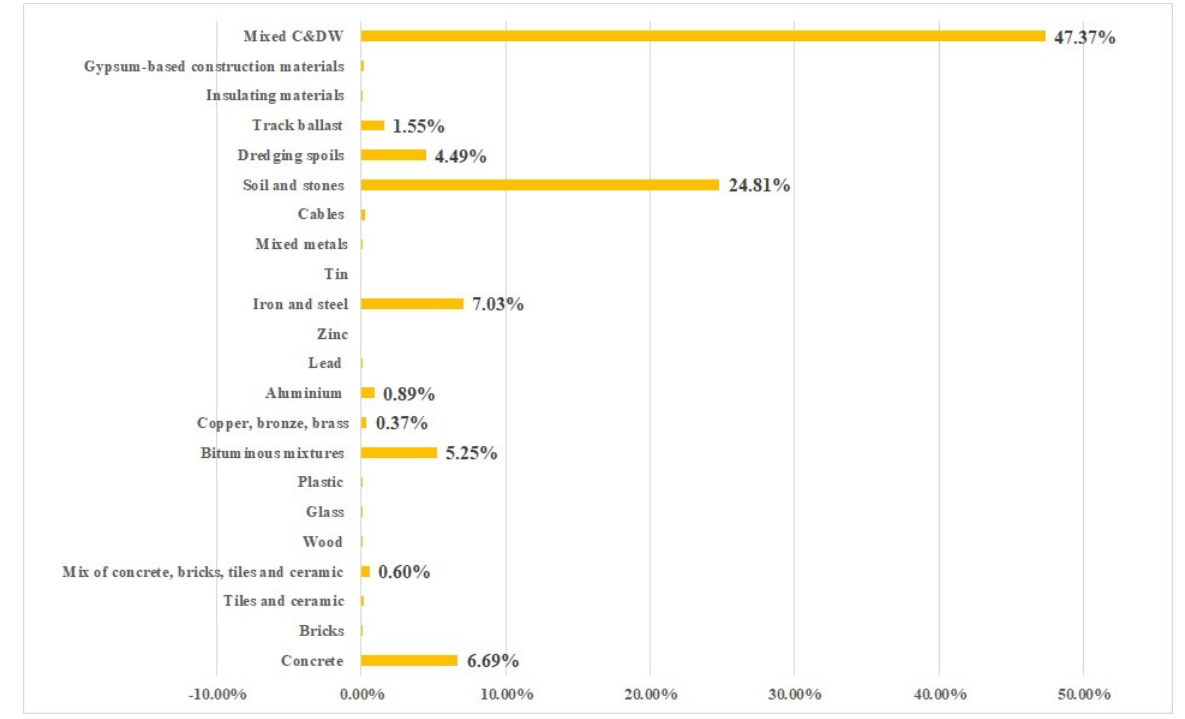
Figure 2. Main fractions composing the amount of C&DW produced in the year 2017 in the Metropolitan City of Naples.